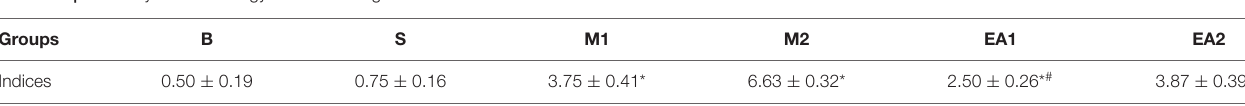
FIGURE 2 | Hematoxylin eosin (HE) staining results of the synovial tissue. (A-b) Group B; (B-b) Group S; (C-b) Group M1; (D-b) Group M2; (E-b) Group EA1; and (F-b) Group EA2. TABLE 5 | Rabbit synovial histology Krenn Grading